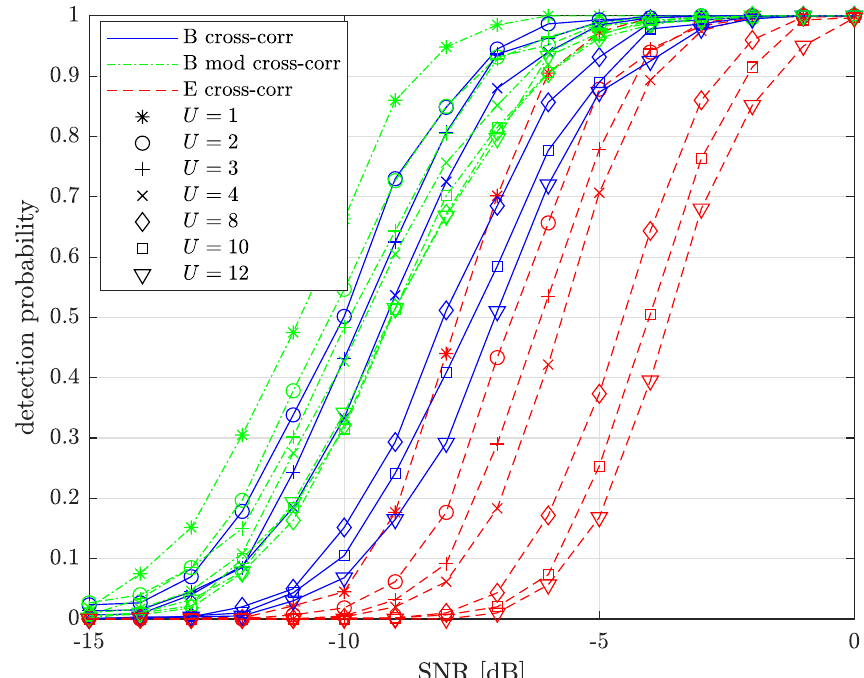
1,2,3,4,8,10,12 , { }